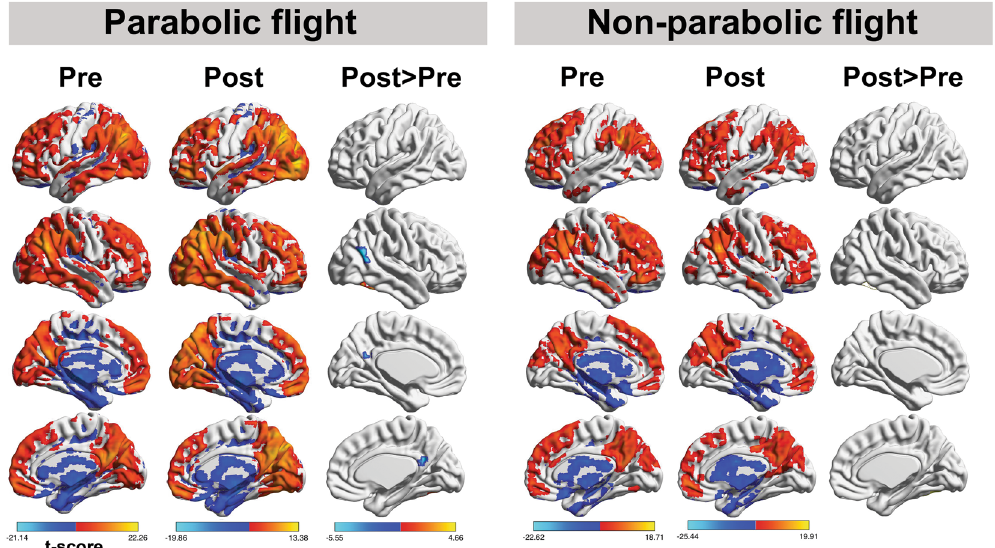
Figure 2. Group-level explorative analysis was performed to localize modifications in global connectivity before and after participation to the parabolic flight (n = 28) and before and after scopolamine intake in the non-parabolic flight group (n = 12). The spatial patterns represent average maps of higher (red) and lower (blue) intrinsic connectivity contrast scores, with a greater score representing greater average strength of the correlations in a given voxel. Statistical maps are rendered on a surface template and are thresholded at cluster- level family wise error rate p < 0.05 (two-sided, permutation testing).